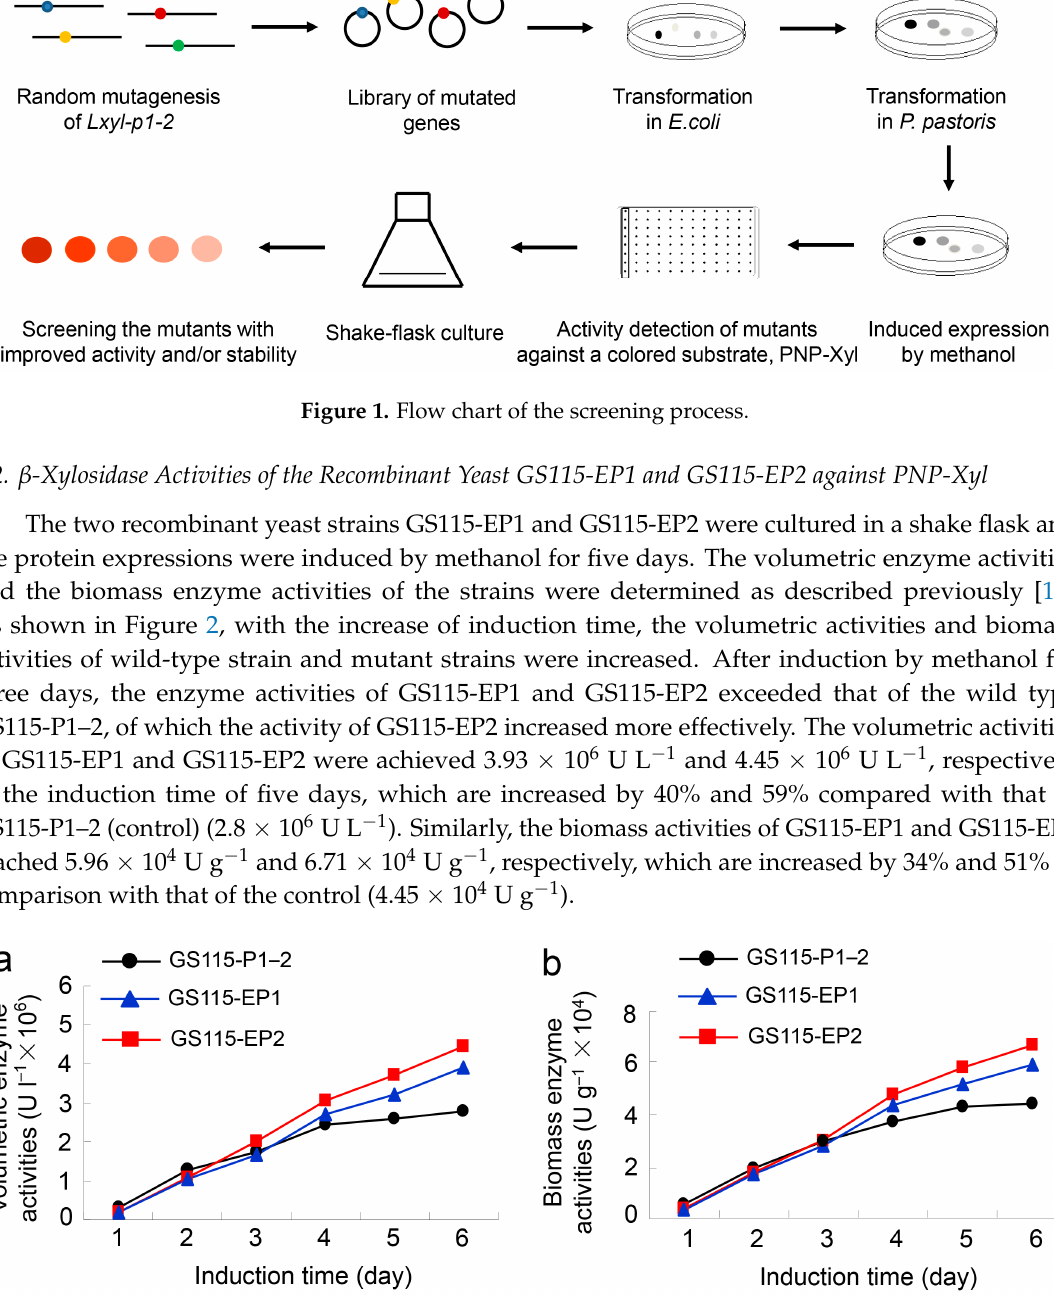
Figure 2. β -Xylosidase activities of the recombinant yeasts GS115-EP1 and GS115-EP2 against PNP-Xyl. ( a ) Volumetric enzyme activities; ( b ) biomass enzyme activities.